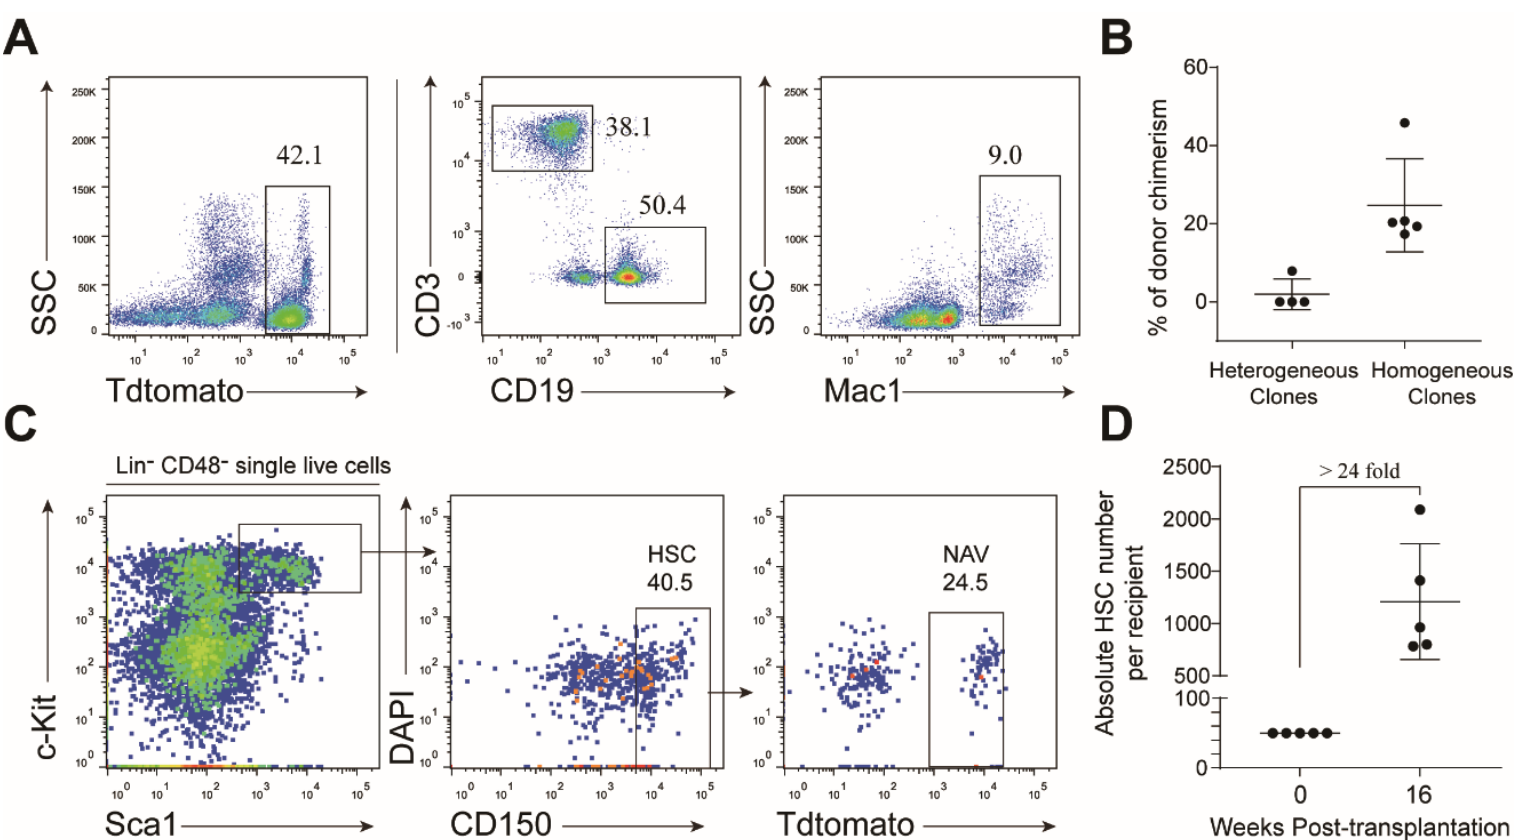
Figure 7. Evaluation of multi-lineage potential of cultured single NAV HSC by transplantation. ( A ) Representative flow cytometric analysis of donor (NAV)-derived lineages in recipients transplanted with 10-day cultured cells. Fifty cells collected from each colony were transplanted into sublethally irradiated (6.5 Gy) mice (CD45.1). Flow cytometric analysis was performed to assess the lineages of donor-derived cells in peripheral blood 16 weeks post-transplantation. ( B ) The percentage of donor-derived cells in peripheral from heterogeneous and hemogeneous clones. Data are presented as means ± SD. ( C ) Flow cytometric analysis of donor (NAV)-derived phenotypic HSC in the bone marrow of recipients 16 weeks post-transplantation. ( D ) The absolute number of donor (NAV)-derived HSC. Data are represented as means ± SD. Data are either representative plots from two independent experiments ( A , C ), or are pooled from two independent experiments ( B , D ).